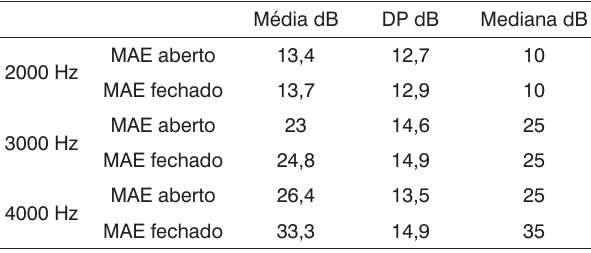
Tabela 1. Análise descritiva dos valores (dB) de gap aéreo/ósseo encontrados na população estudada (n=141